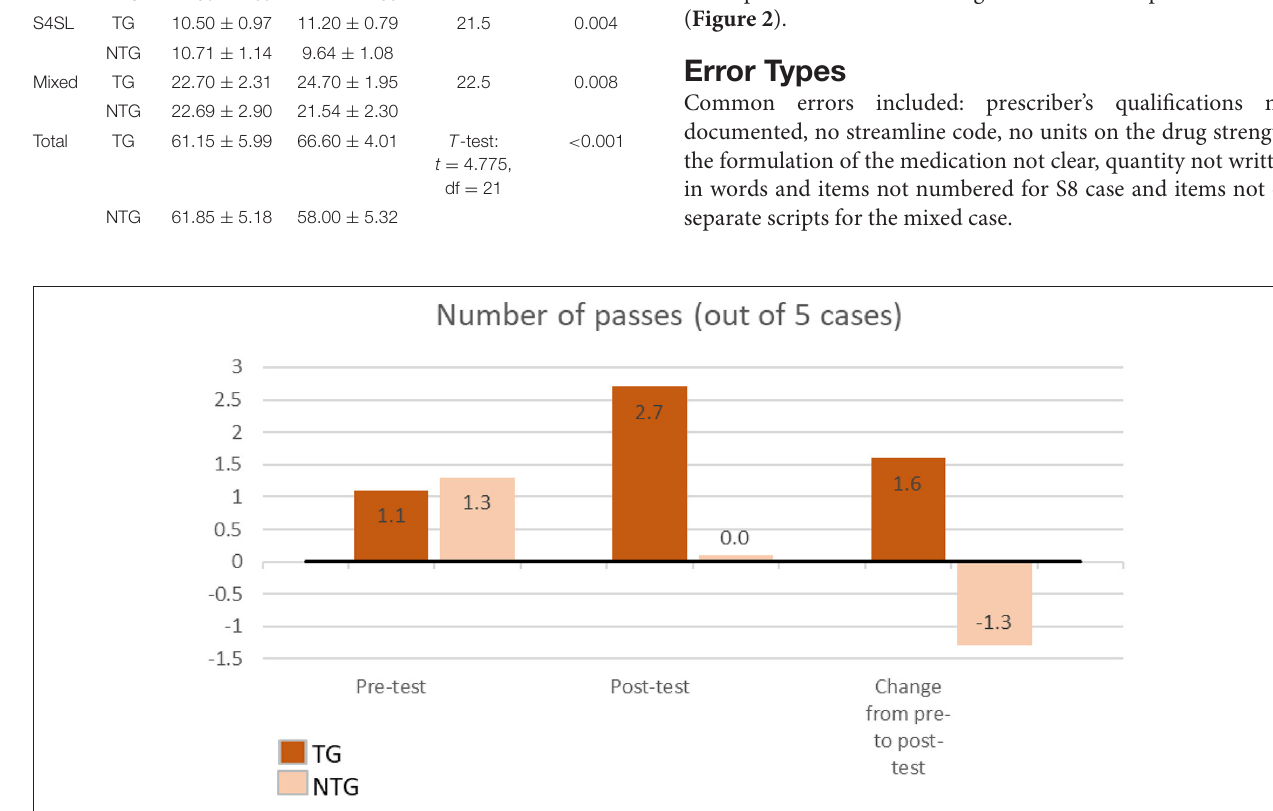
Frontiers in Medicine |